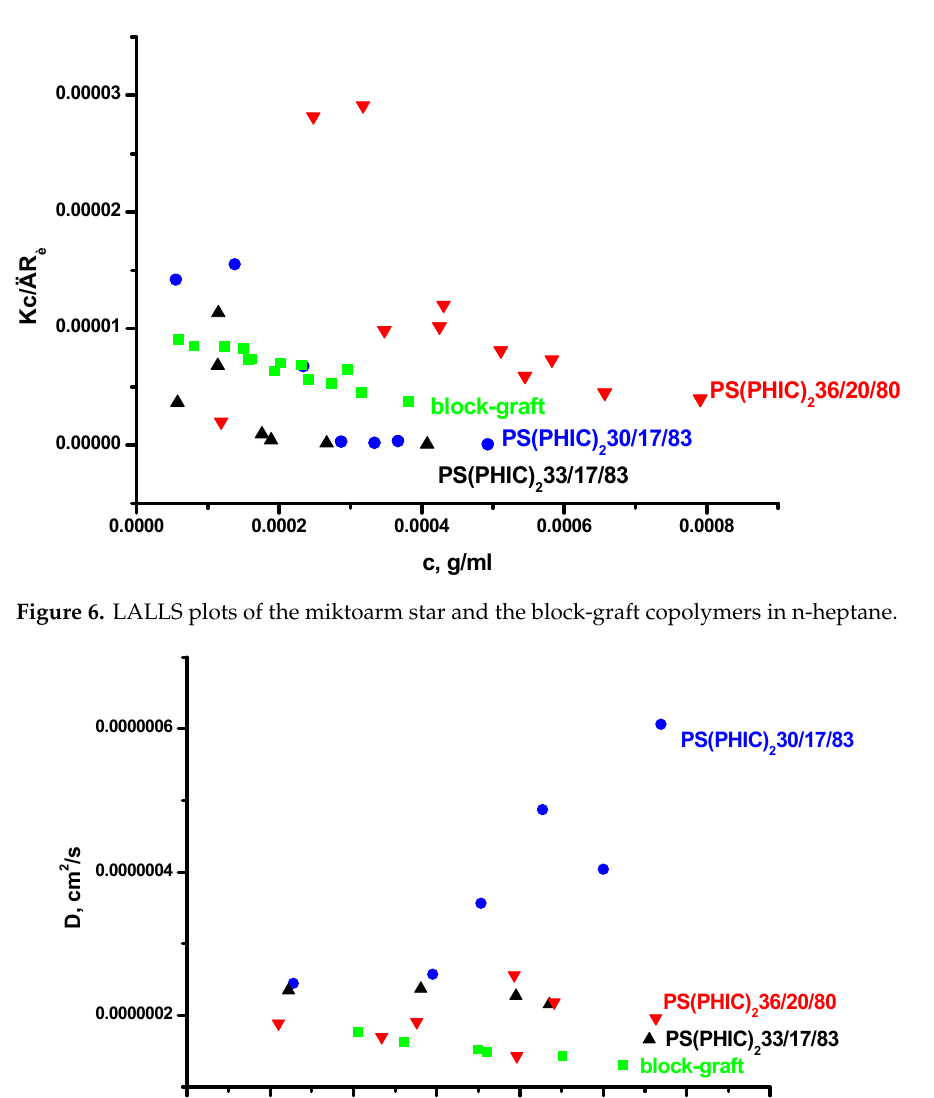
Figure 7. DLS plots of the miktoarm star and the block-graft copolymers in n-heptane.